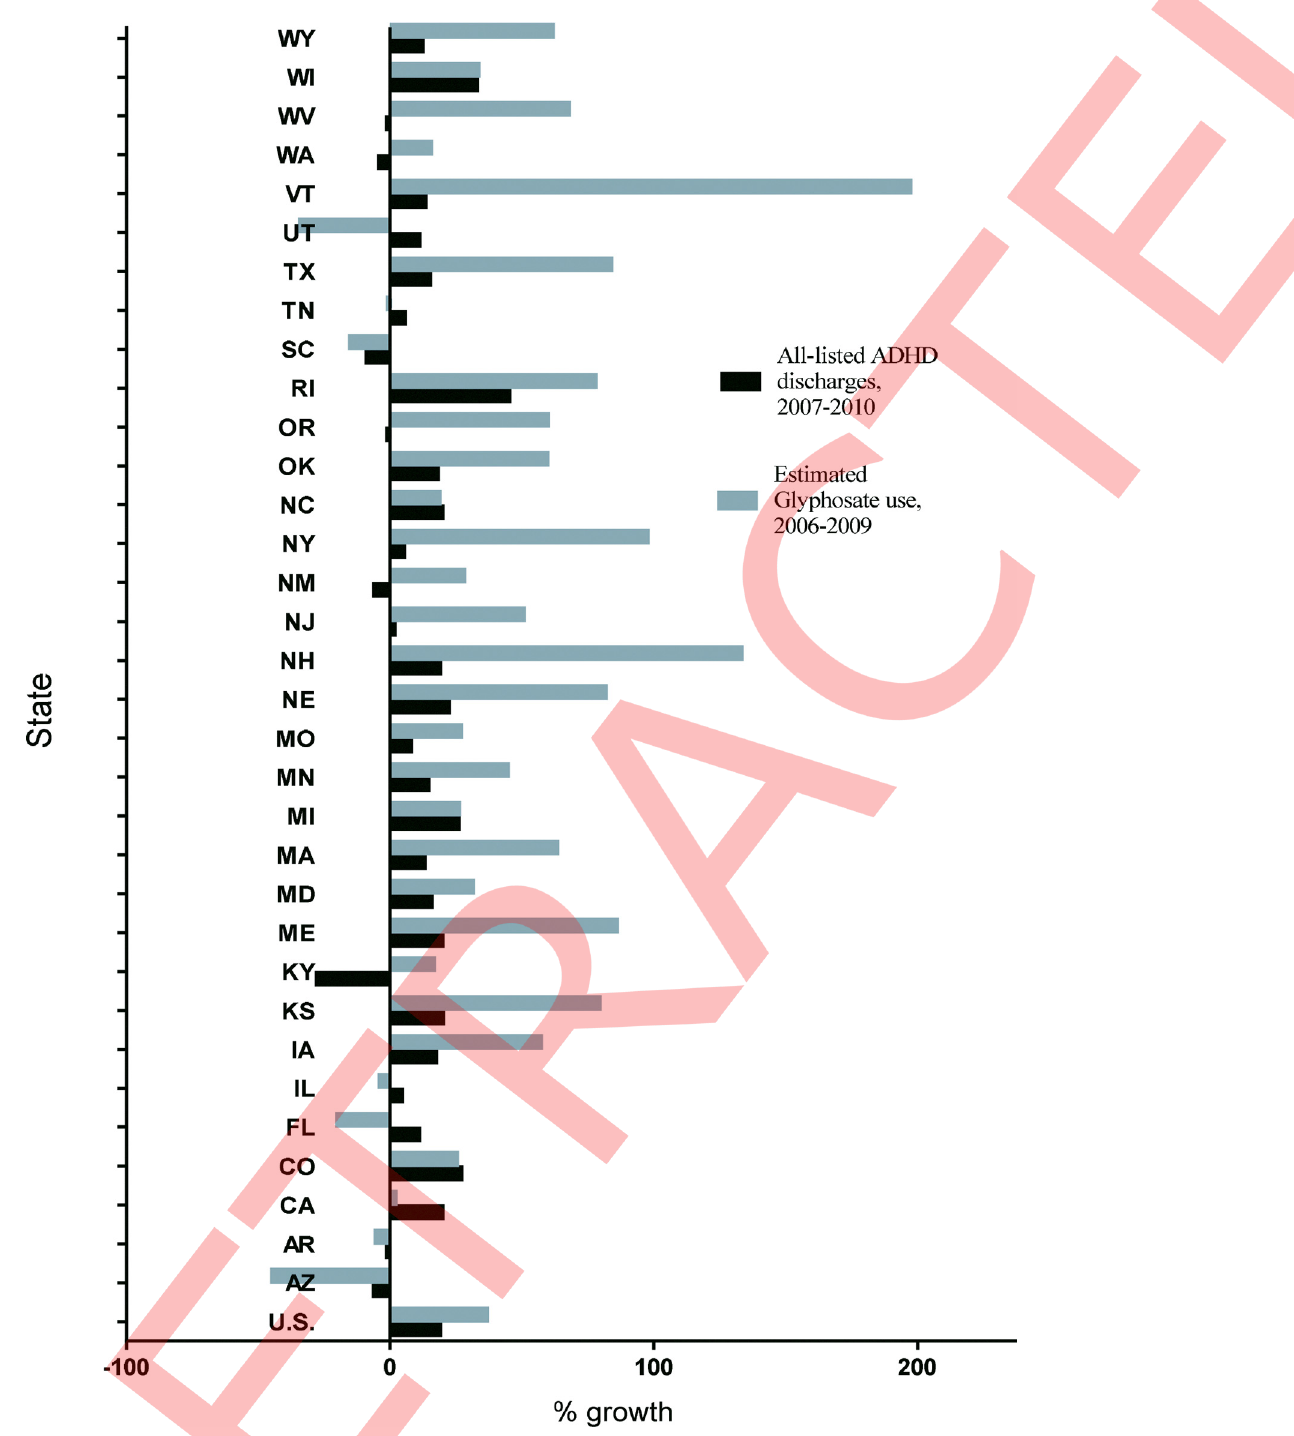
Fig 2. Percent change in estimated glyphosate use (2006 – 2009) and all-listed ADHD hospital discharges among HCUPNET available states (2007 – 2010).